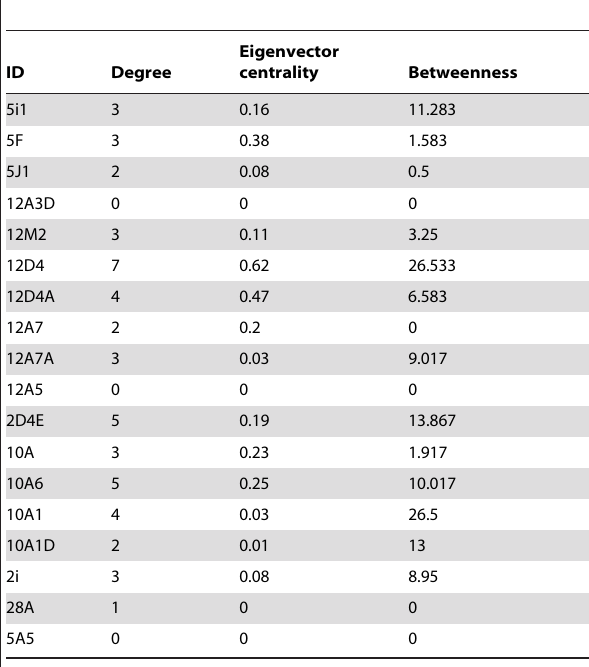
Table 3. Individual details of degree, eigenvector centrality and betweenness for the contact network